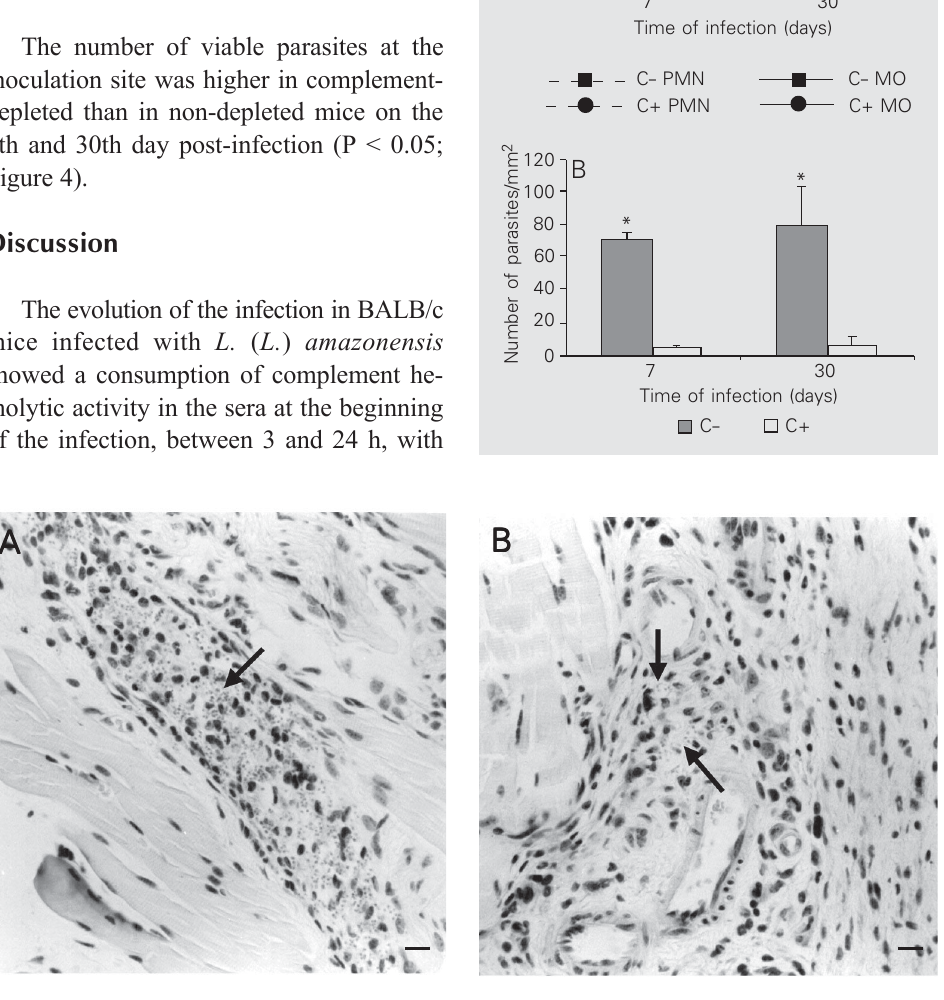
Figure 2. Morphometric analy- sis of the Leishmania ( L. ) ama- zonensis subcutaneous inocu- lation site of complement-de- pleted (C-) and complement- non-depleted (C+) BALB/c mice, showing the inflamma- tory reaction (A) and the para- site burden of the lesion (B). Data are representative of three separate experiments yielding similar results. Data are re- ported as the mean ± SD for 5 animals per group. MO = mono- nuclear cells, PMN = polymor- phonuclear cells. *P < 0.05 compared to non-depleted ani- mals (one-way ANOVA).